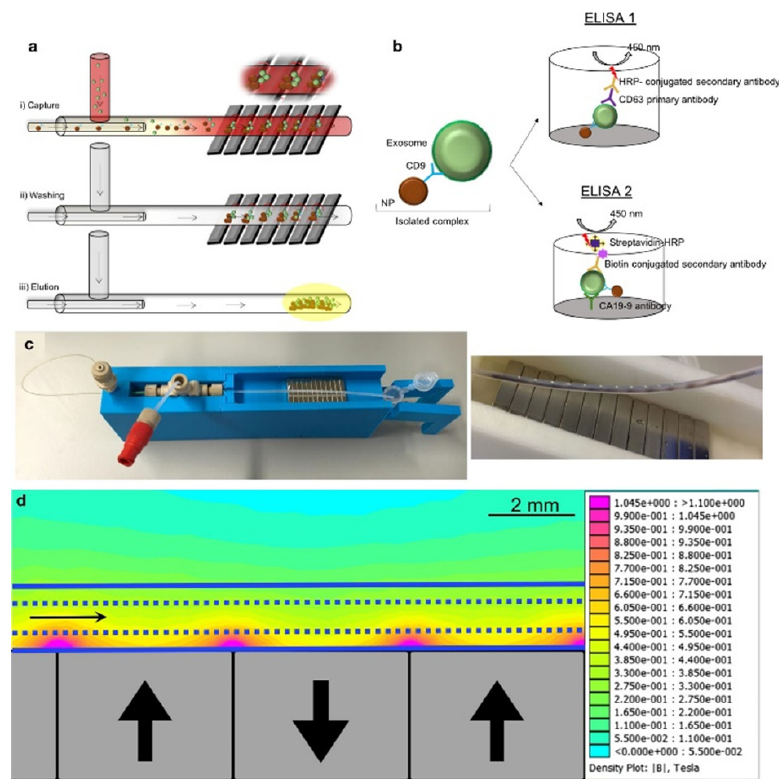
Figure 5. ( a ) Exosomes are captured by antibody functionalized nanoparticles (Fe 3 O 4 -EDC-NHS- NP: anti CD9). ( b ) ELISA was performed to quantify exosomes and to measure CA19-9 levels. ( c ) Experimental setup and capture of the magnetic particles in the channel. ( d ) Simulation of the mag- netic gradient. Reproduced with permission from Sancho-Albero et al., 2020 under Creative Com-